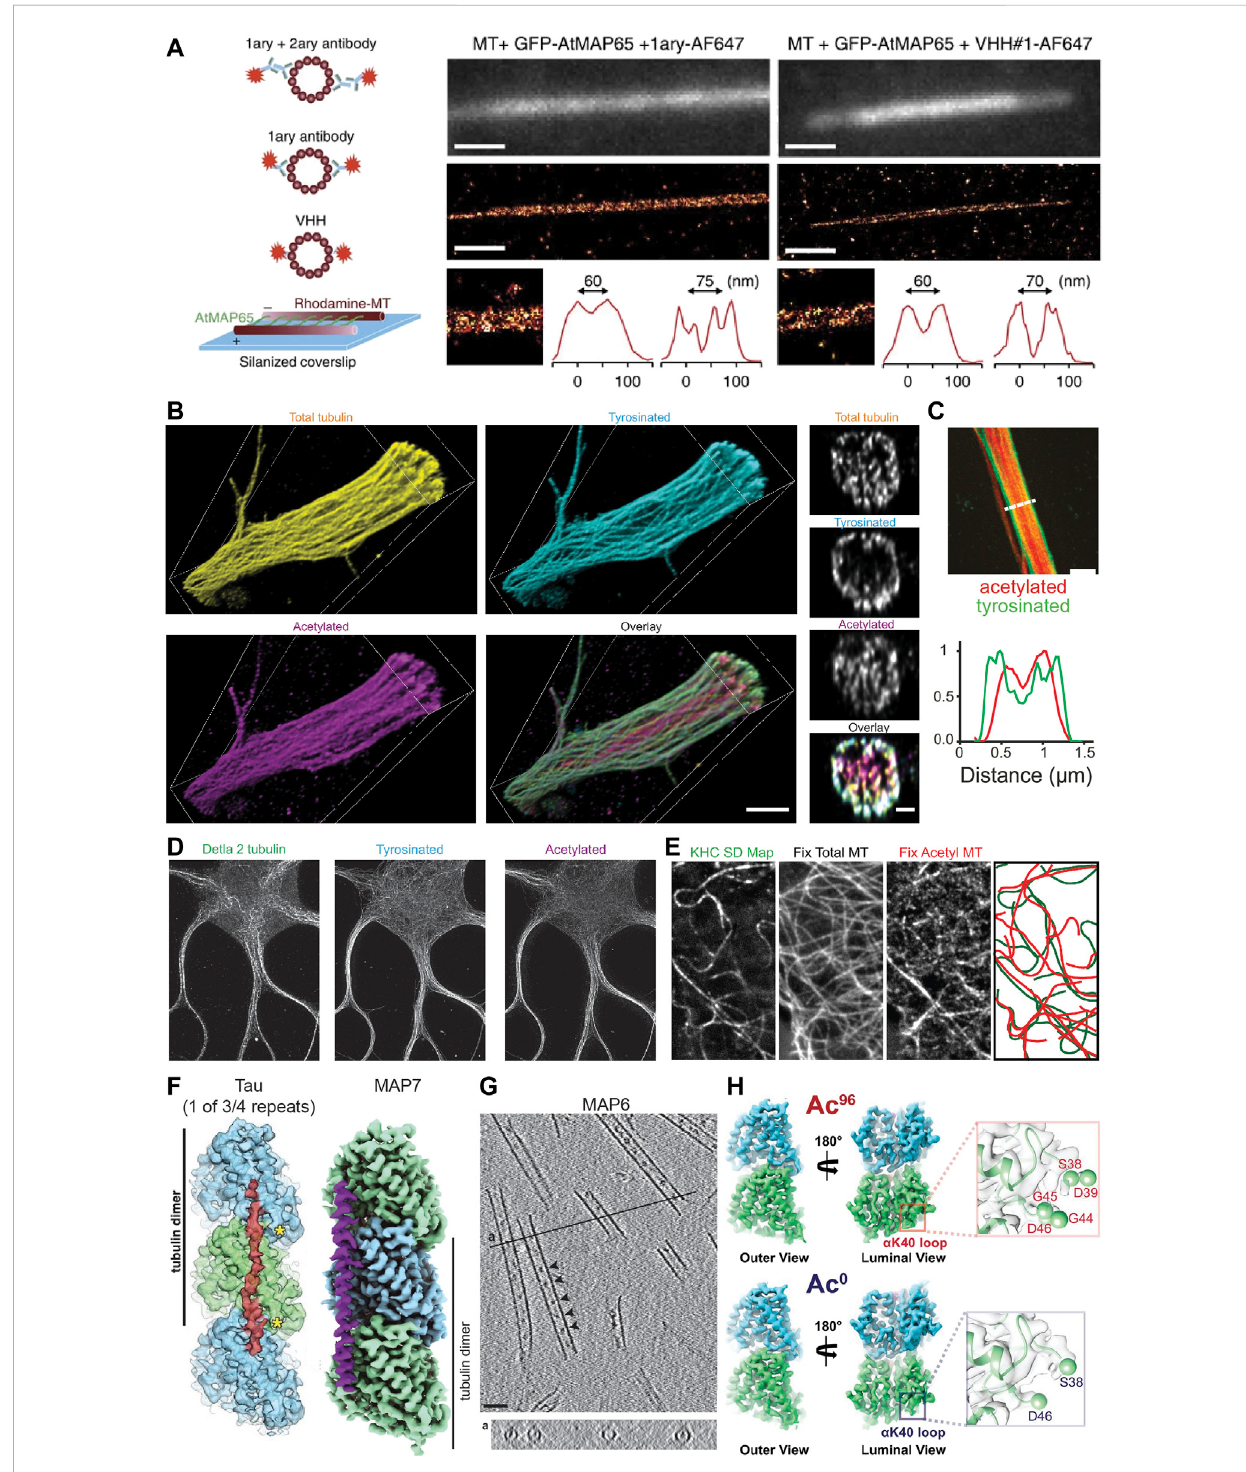
Methods for visualizing aspects of the MAP code and the tubulin code. (A) An illustration showing different labelling strategies [primary + labelled secondary,labelledprimary,andlabellednanobody(hereVHH)]usedinsinglemoleculelocalizationmicroscopyapproachessuchasSTORMtohighlight their effect on the effective microtubule diameter. Experimental set-up to create microtubules cross-linked with a known distance of 30 – 40 nm between microtubules or 55 – 65 nm between microtubule centers using MAP65/Ase1 from A. thaliana . An experimental comparison of the observed peak-to-peak distances for microtubules crosslinked with MAP65 when imaged using a labelled primary antibody (left) or a labelled nanobody (right). Note that microtubules can be more easily distinguished with the nanobody. Taken from (Mikhaylova et al., 2015). (B) Volumetric 3D rendering of microtubulesinadendriteasimagedwith four-fold expansion microscopy,aswell ascorrespondingcross-sections.Shownaretotaltubulin,tyrosinated tubulin, acetylated tubulin, and an overlay. Note that acetylated microtubules are enriched centrally, while tyrosinated microtubules are enriched peripherally. Takenfrom (Katrukha etal., 2021). (C) A StimulatedEmission Depletion (STED) microscope imageof adendritefrom aDIV7 rat hippocampal